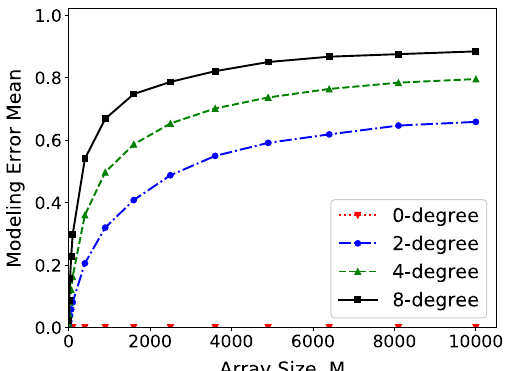
Fig. 3 Average modeling error changes with the number of base-station antennas. The plot is based on simulated channels with different angle spreads, respectively